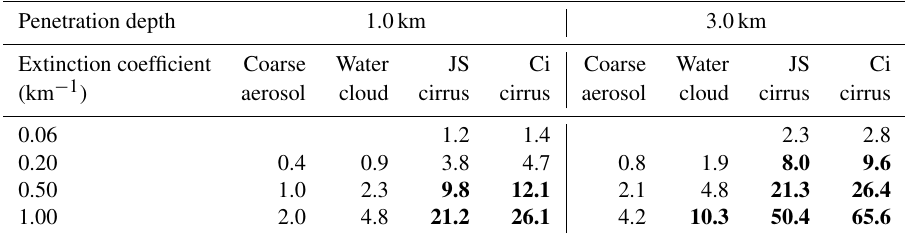
Table 4. Multiple-scattering contribution to lidar signals in per cent (%) of the single scattering. The distance to the cloud base is 1km; the lidar RFOV is 1.0mrad. Values exceeding 5% threshold are in bold font.